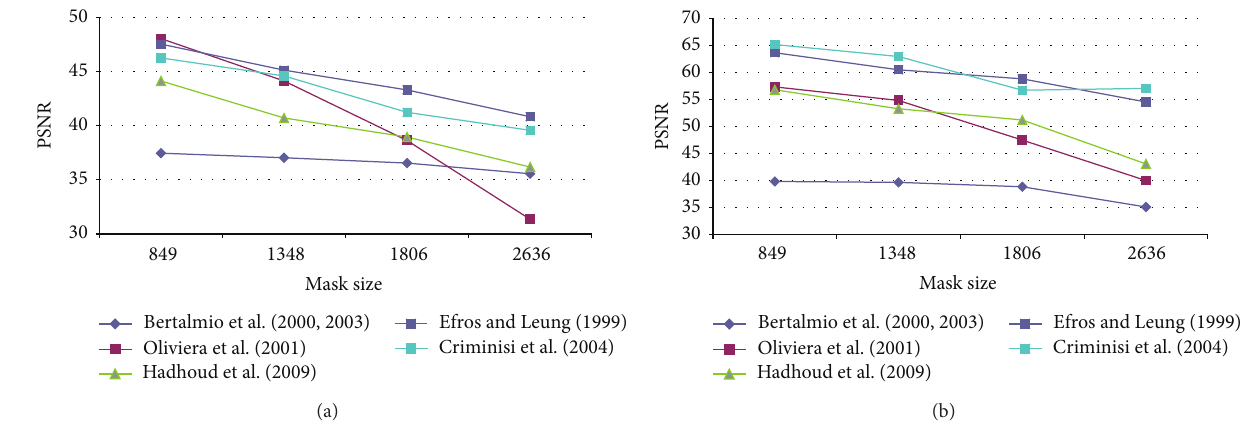
Figure 8: PSNR results for (a) helicopter and (b) lands test image.